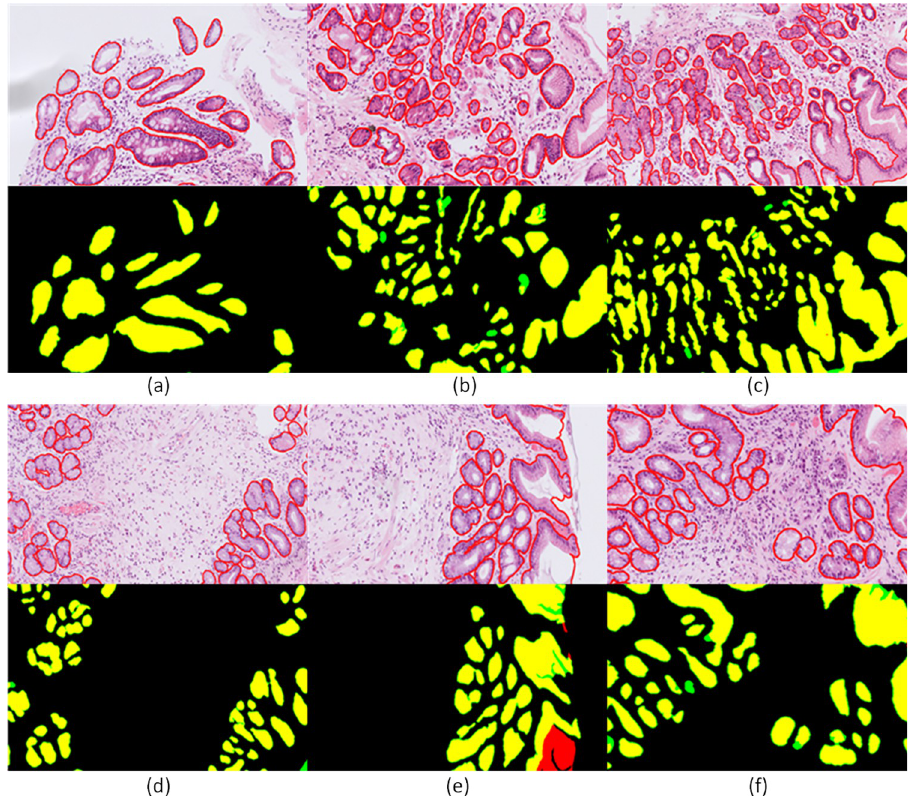
Fig 5. Gland segmentation results of GAGL-VTNet model on GAGL dataset in comparison with ground truth: Yellow color (true positive), red color (false positive), green color (false negative).